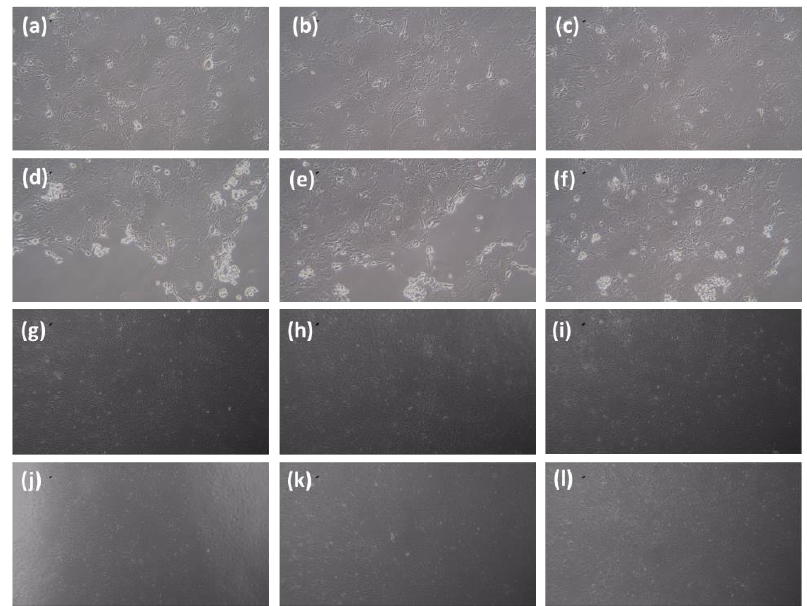
Figure 11. Microscopic image of 3T3-L1 Fibroblast cells with control ( a – c ) and SiO 2 /ZrO 2 /TMSPMA post composite ( d – f ) incubation period of 1 day, ( g – i ) incubation period of 4 days, and ( j – l ) 7-day incubation period.